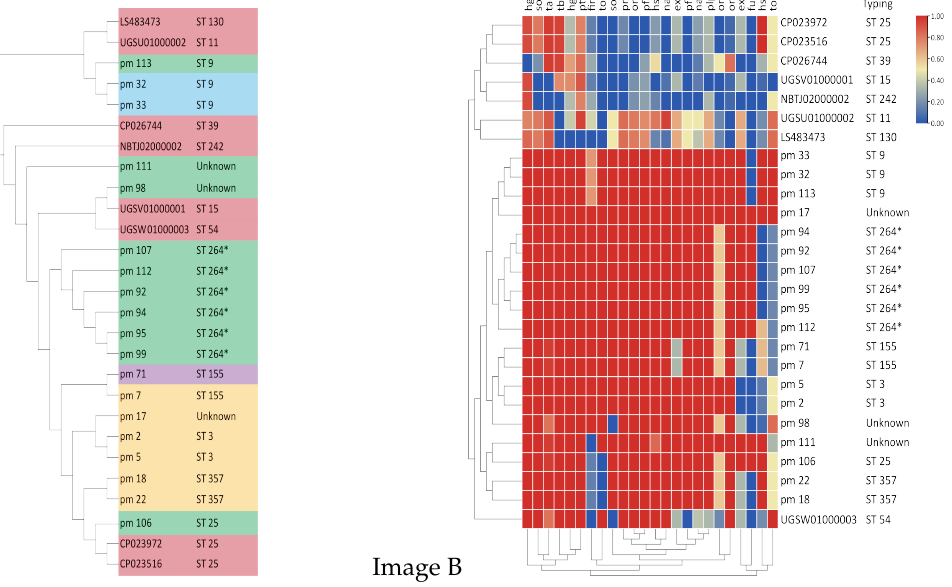
Figure 3. ( Image A ) Phylogenetic tree of 27 P. multocida strains. The eight P. multocida strains whose entire genomes were downloaded from GenBank are highlighted in red. In total, 19 P. multocida from cats were shown in other colors. Distinct colors in cat-derived P. multocida represented isolation from different cafes. ST264* indicated that their MLST type was the most similar to ST264. ( Image B ) The heatmap of the distribution of genes that encode the virulence factors of P. multocida . The relative abundance on a Z scale of 0 to 1 across each row served as the scale for the